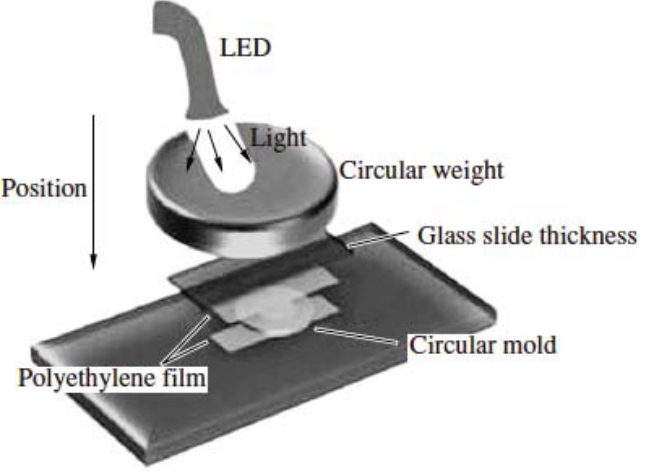
Figure 4. Schematic drawing of the specimen’s preparation for microhardness